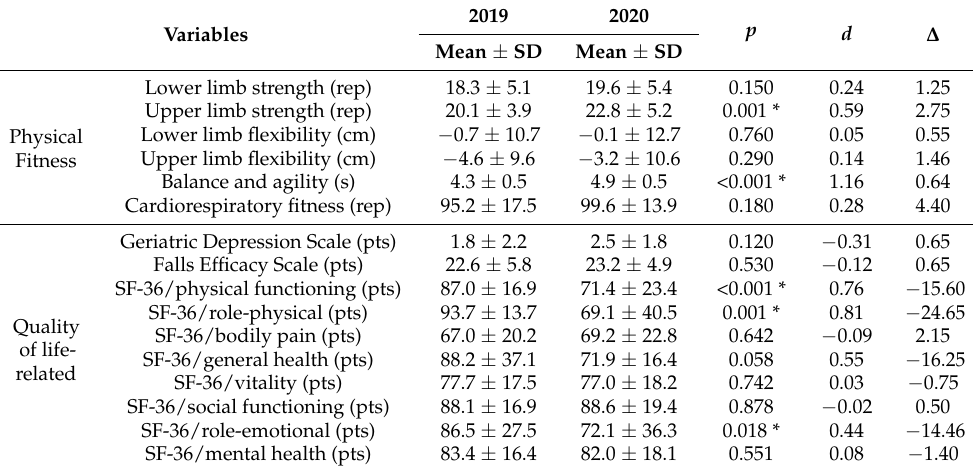
Table 1. Mean, standard deviation, and effect size of variables of physical fitness and quality of life of older adults before and after an online exercise training